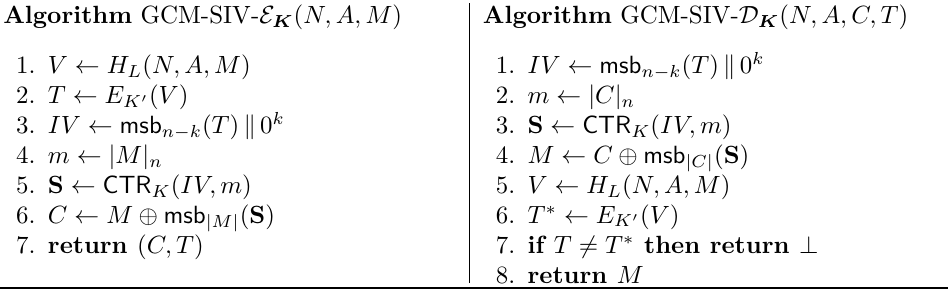
Figure 1: Definitions of GCM-SIV- E K ( N, A, M ) and GCM-SIV- D K ( N, A, C, T